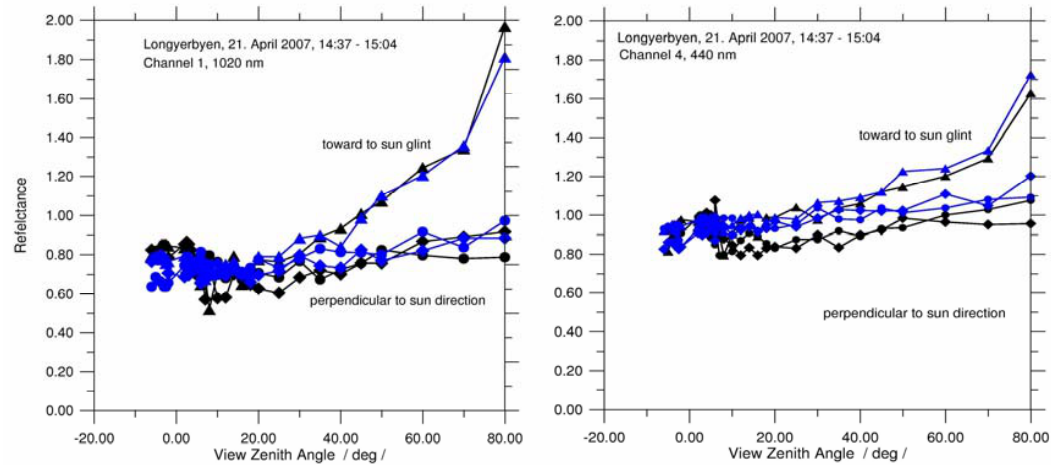
Fig. 7. Snow reflectance functions taken in Longyearbyen at 1020nm (left) and 440nm (right). Different curves represent different measure- ments. 1 Figure 7: Snow reflectance functions taken in Longyearbyen at 1020 nm (left) and 440 nm (right). Different curves represent different measurements.